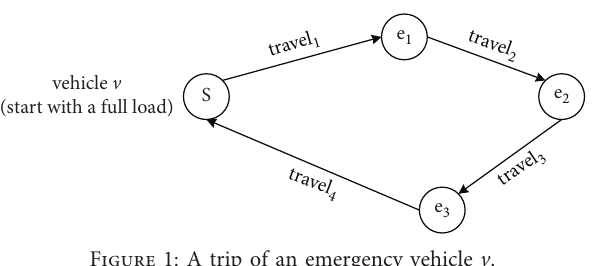
Figure 1: A trip of an emergency vehicle v